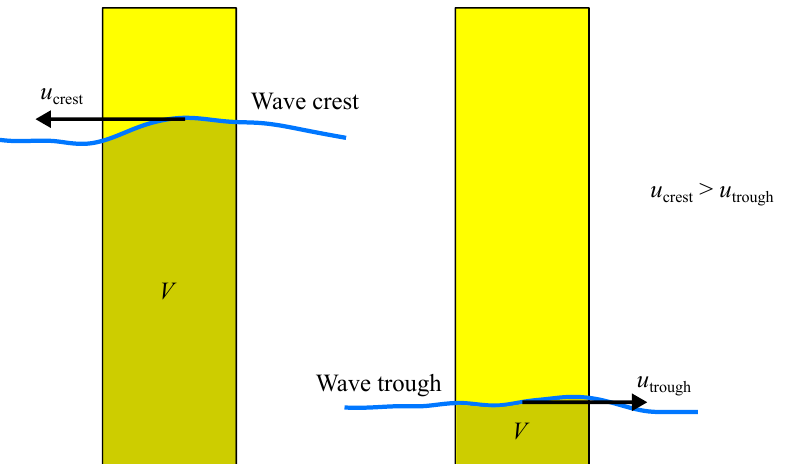
Figure 3. Illustration of the difference in wave velocities over the surface-piercing elements. V indicates the submerged